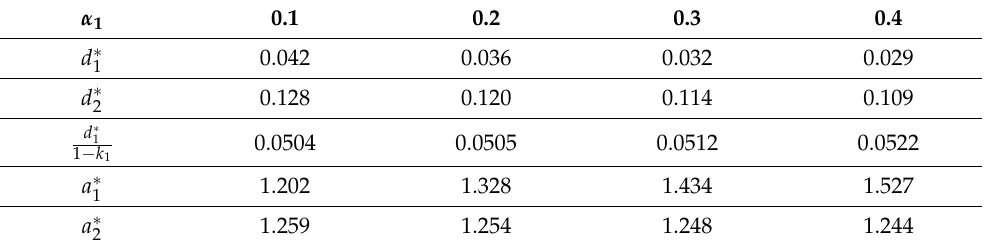
Table 2. The effects of α 1 .